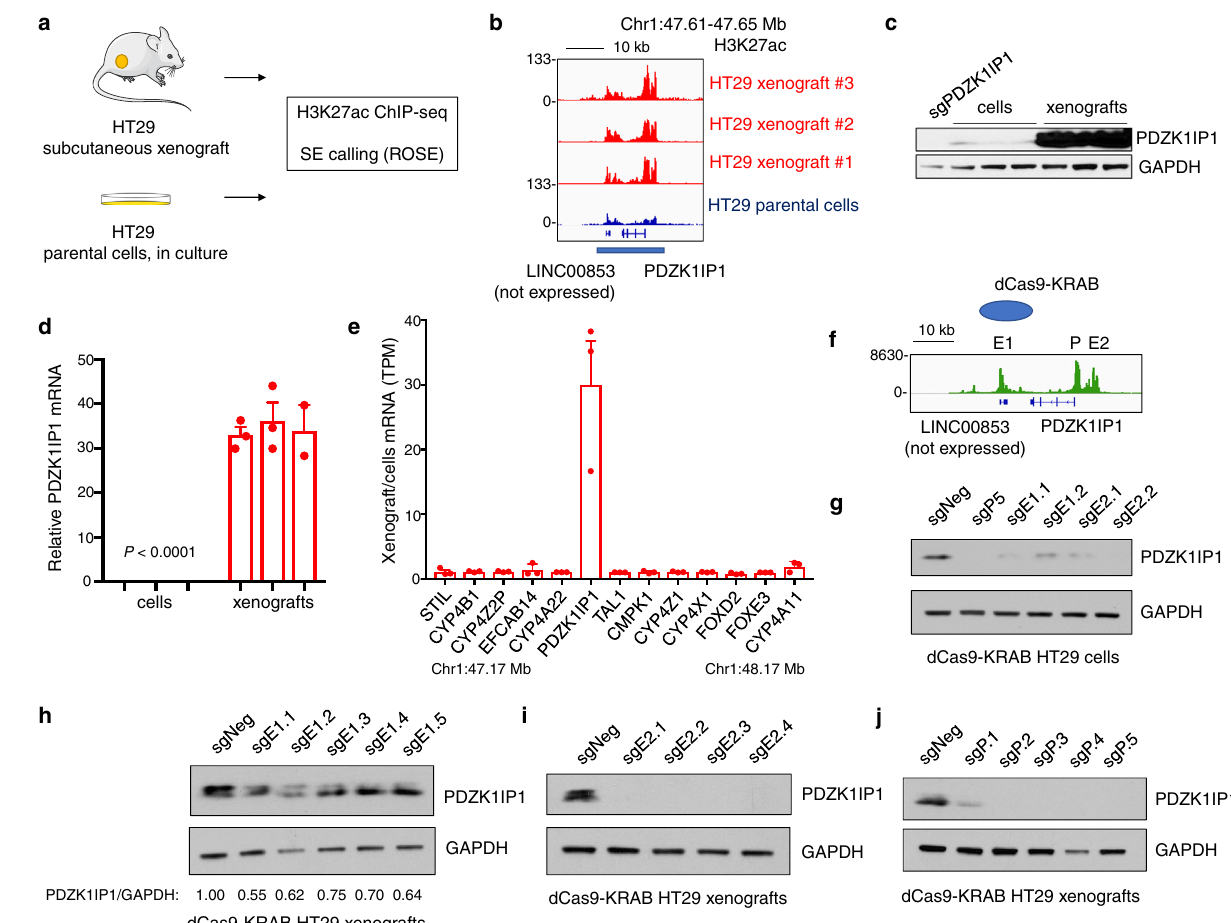
Fig.4|Xenotransplantationrestoresthe PDZK1IP1 super-enhancerandCRISPR interference attenuates expression. a Xenotransplantation and tumor ChIP-seq experimentoverview.FigureadaptedfromSMARTServierMedicalArt,reproduced with permission, licensed under a Creative Commons Attribution 3.0 unported license. b H3K27ac ChIP-seq track of the PDZK1IP1 SE (underlined) in HT29 xeno- grafts ( n =3 independent tumors) or HT29 parental cells maintained in culture. Y-axesof allChIP-seqtracksarescaledtothesamerange[0 – 133]. c Immunoblotof PDZK1IP1 protein levels between HT29 xenografts ( n =3 independent tumors) or HT29 parental cells maintained in culture ( n =3 biological replicates). d Quantitative real-time PCR (qRT-PCR) of PDZK1IP1 mRNA expression between HT29 xenografts ( n =3 independent tumors) or HT29 parental cells maintained in